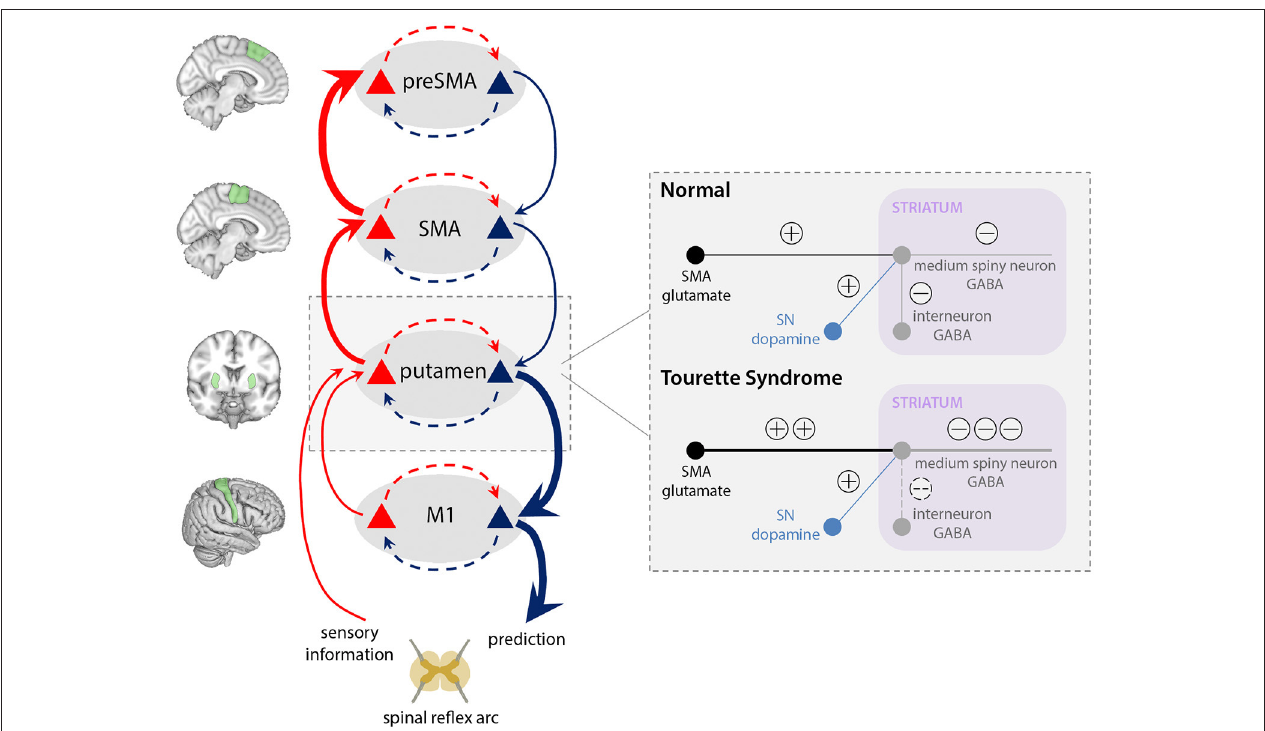
FIGURE 4 | Aberrant integration of cortical inputs within the striatum in TS. Typically, glutamatergic inputs to the basal ganglia direct pathway are regulated by inhibitory interneurons within the striatum, and modulated according to dopamine release by the substantia nigra (SN). In our model of TS, increased cortical signalling from the SMA, combined with reduced regulation of the direct pathway by inhibitory interneurons, leads to increased excitation of the medium spiny striatal output neurons, which results in greater thalamic disinhibition and release of signals for movement to M1. Thus, a tic is generated, leading to ascending prediction error signals from putamen (bold red arrows) for a movement that was not predicted within preSMA, and which is “explained away” as an “unvoluntary”